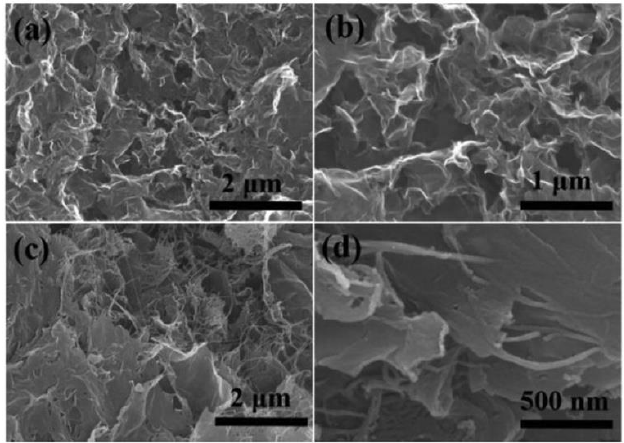
Figure 6. SEM micrographs for the RGO aerogels ( a , b ); GCT aerogels ( c , d ). Reproduced with permission from Reference [42], Elsevier 2019. (RGO—reduced graphene oxide, GCT—graphene / carbon nanotube composite).